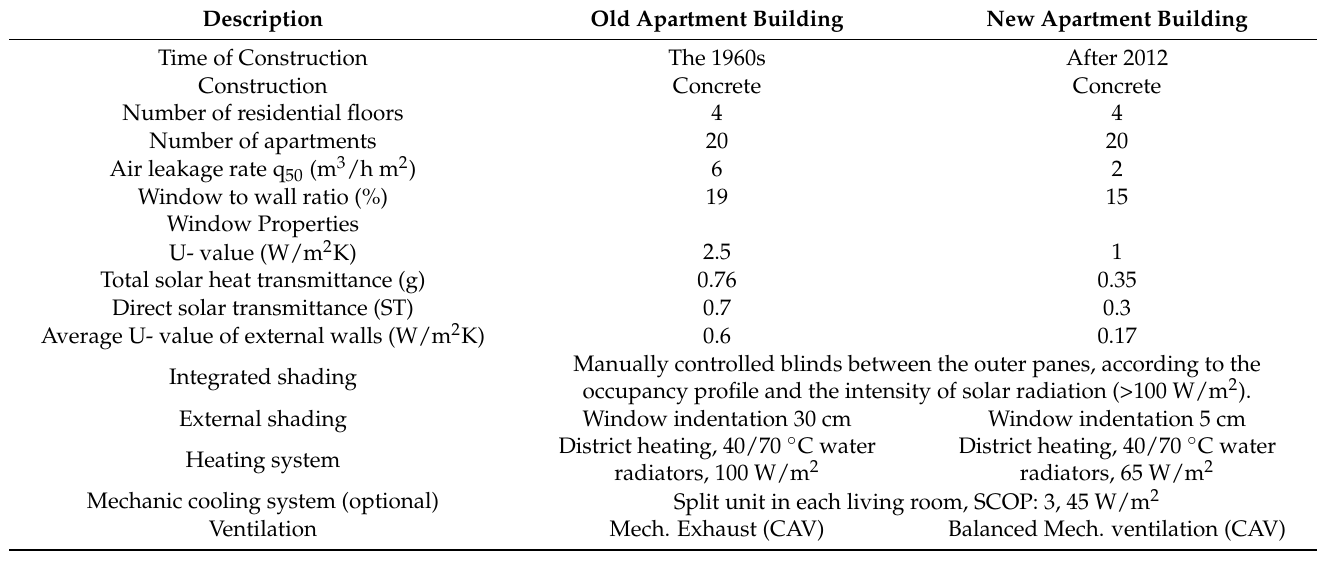
Table 1. Construction properties of the basic form of the old and new example apartment buildings.